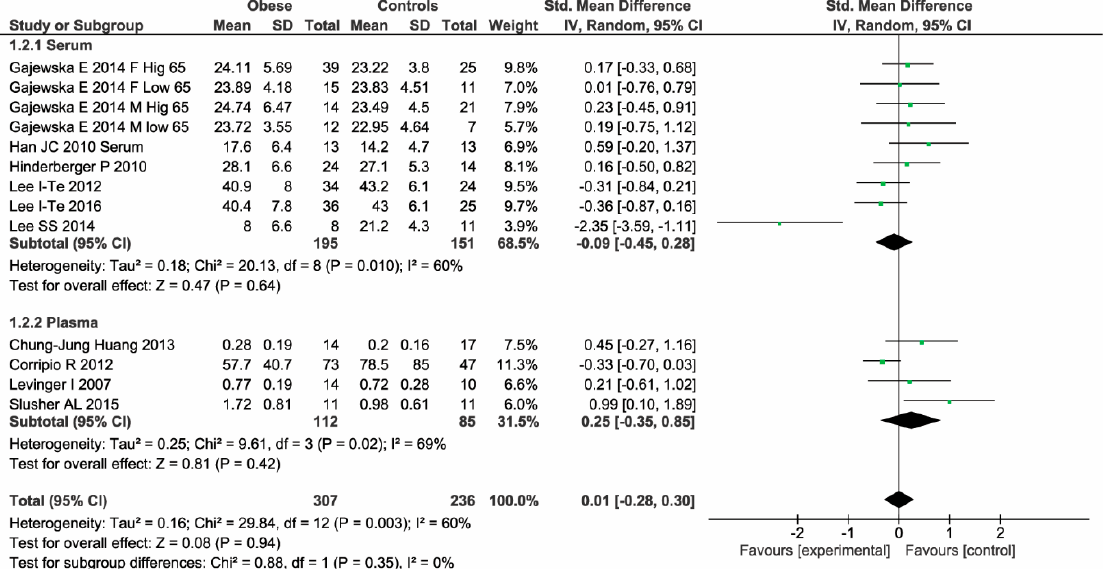
Figure 2. Brain derived neurotrophic factor (BDNF) levels in obese patients and controls. Table 2. Subgroup analysis: stratification of the analysis according to different BDNF matrices used for BDNF measurements.